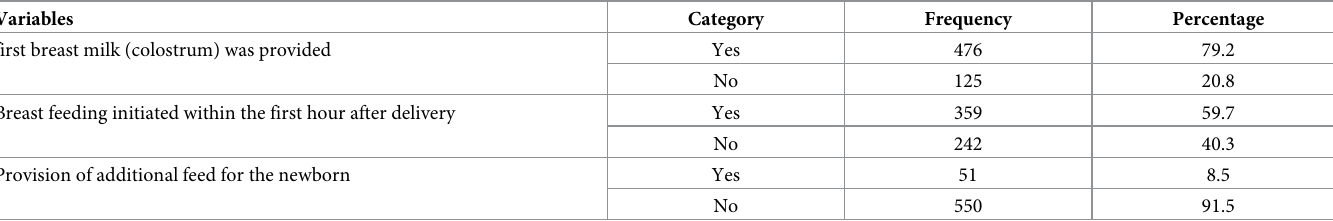
Table 7. Breast feeding practice among home delivered women, in Guto Gida district, Oromia regional state, Ethiopia, September 2020, (n = 601). Variables